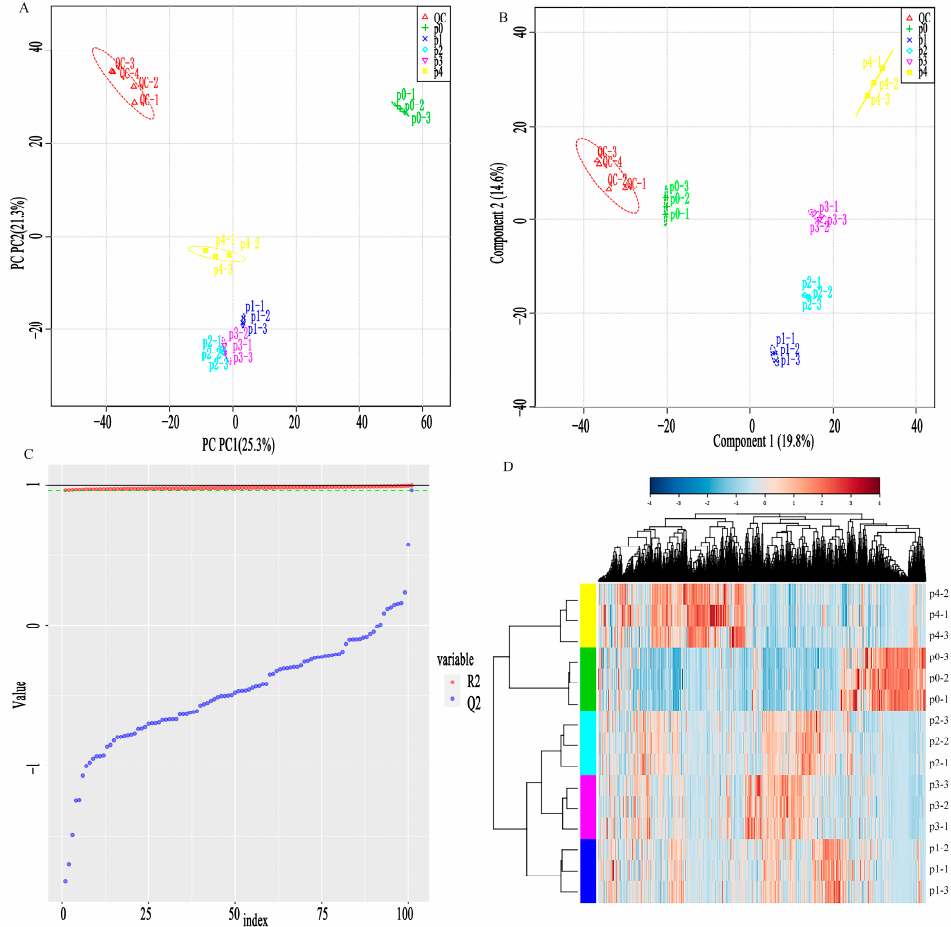
Figure 1. ( A – D ) shows the PCA plot, OPLS-DA plot, OPLS-DA model alignment test plot, and differential metabolite cluster analysis of pineapple leaf residues,